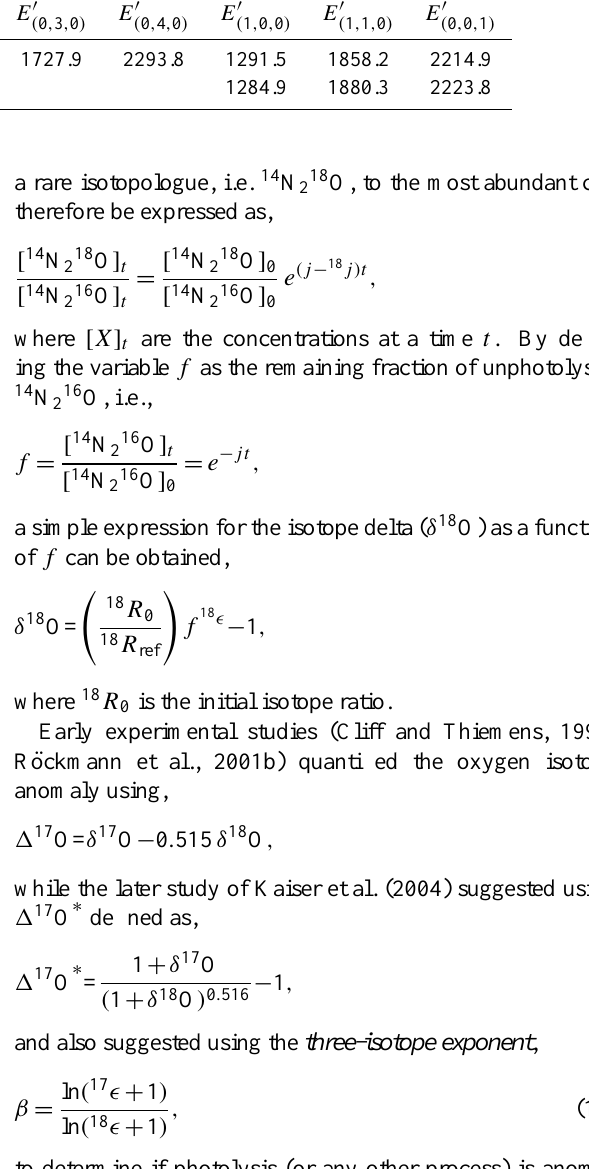
Table 1. Vibrational energies given in cm − 1 of 14 N 216 O, with E 0 values cited in Łapi´nski et al. (2001) and HZPE = 0 . 5 E 0